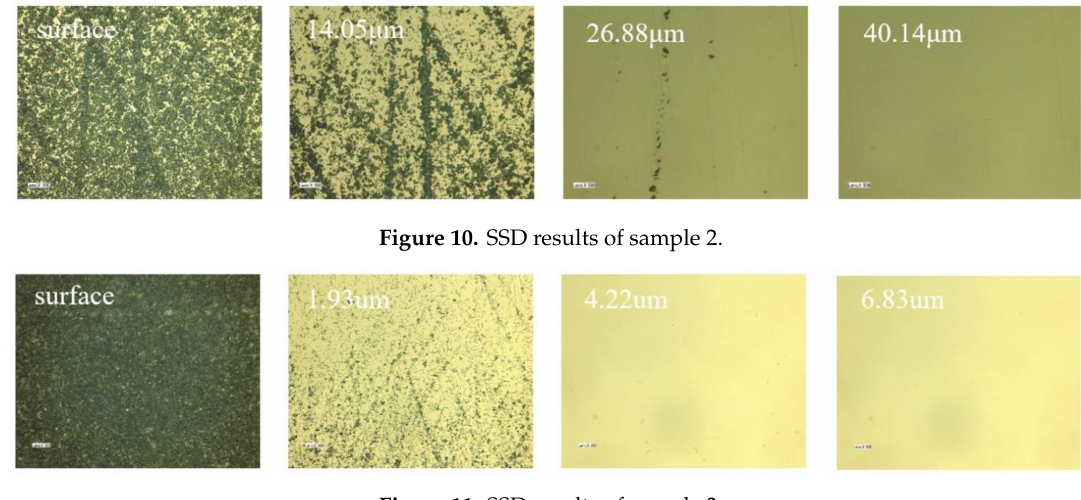
Figure 11. SSD results of sample 3.